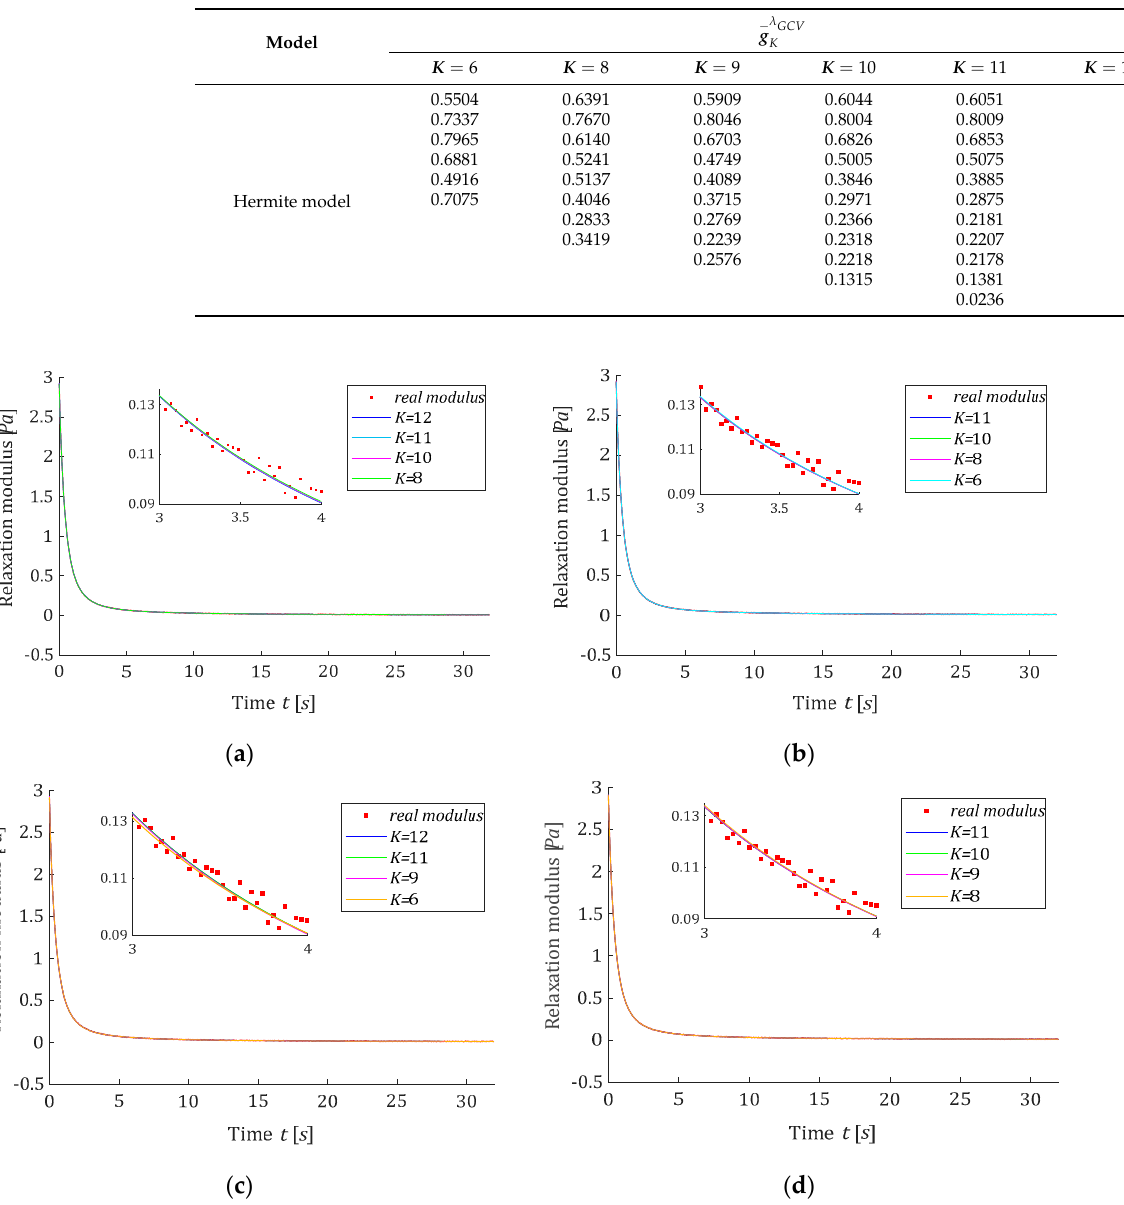
Figure A1. The measurements of the relaxation modulus G ( t ) (59) (red points) from Example 1 and the approximated models 𝐺 (cid:3012) (𝑡) (8): ( a ) Legendre, ( b ) Laguerre, ( c ) Chebyshev, ( d ) Hermite. Table A3. Optimal parameters 𝒈(cid:3365) (cid:3012)(cid:3090) (cid:3256)(cid:3252)(cid:3271) of the relaxation spectrum models from Example 2; the ele-